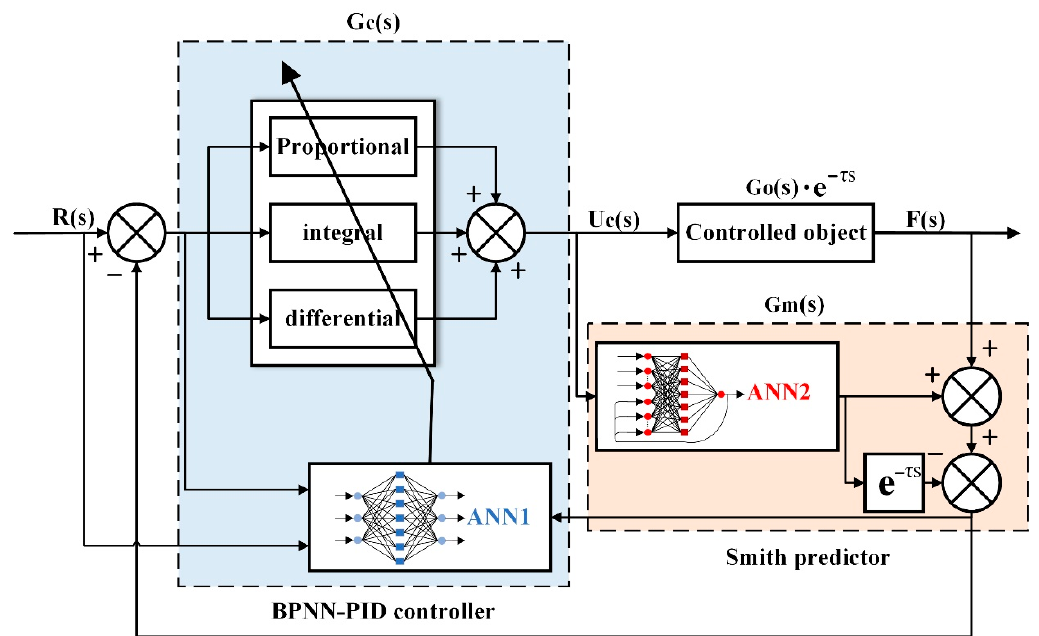
Figure 6. Backpropagation neural network-Smith predictor-proportional–integral–derivative (BPNN-SP-PID) controller structure diagram.